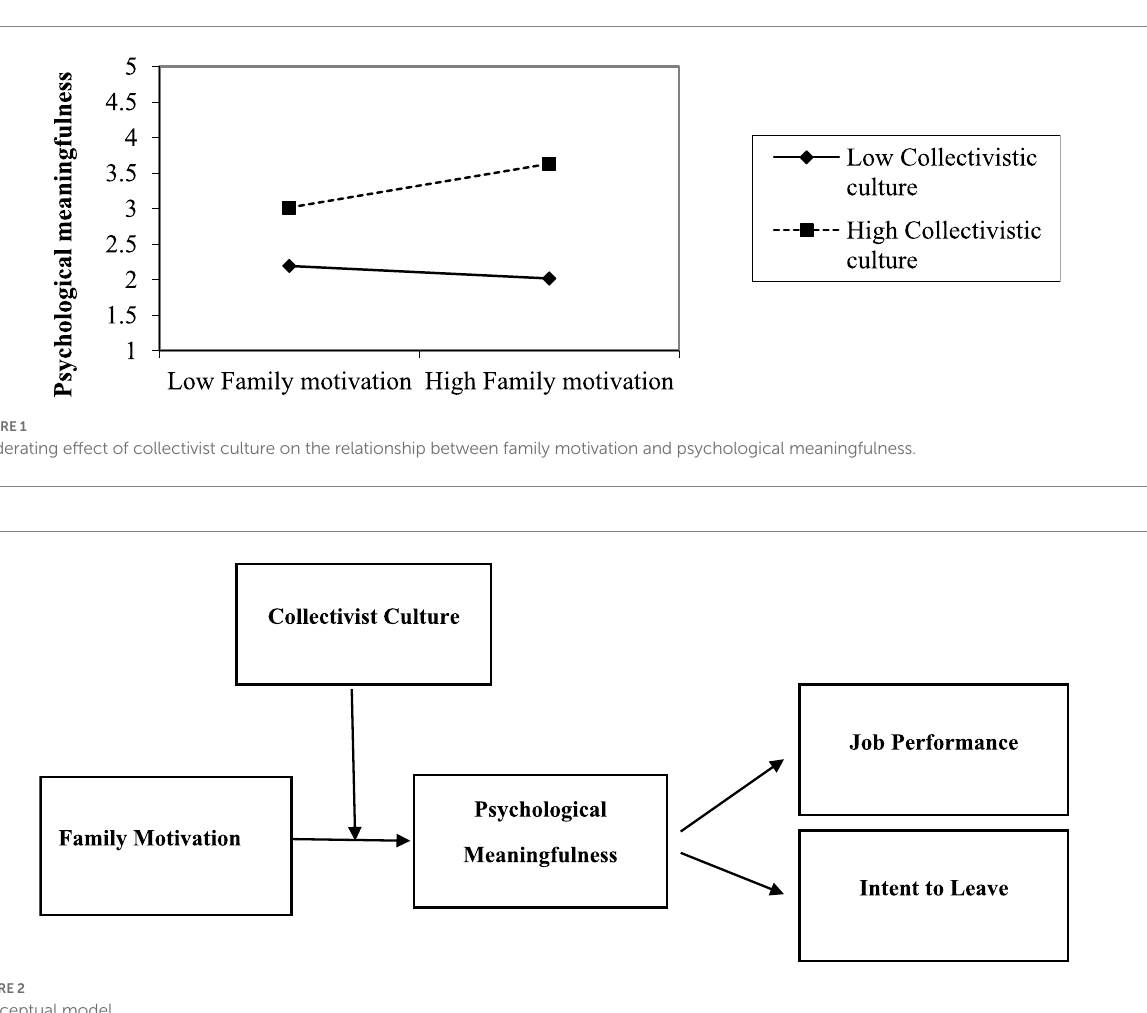
FIGURE 2 Conceptual